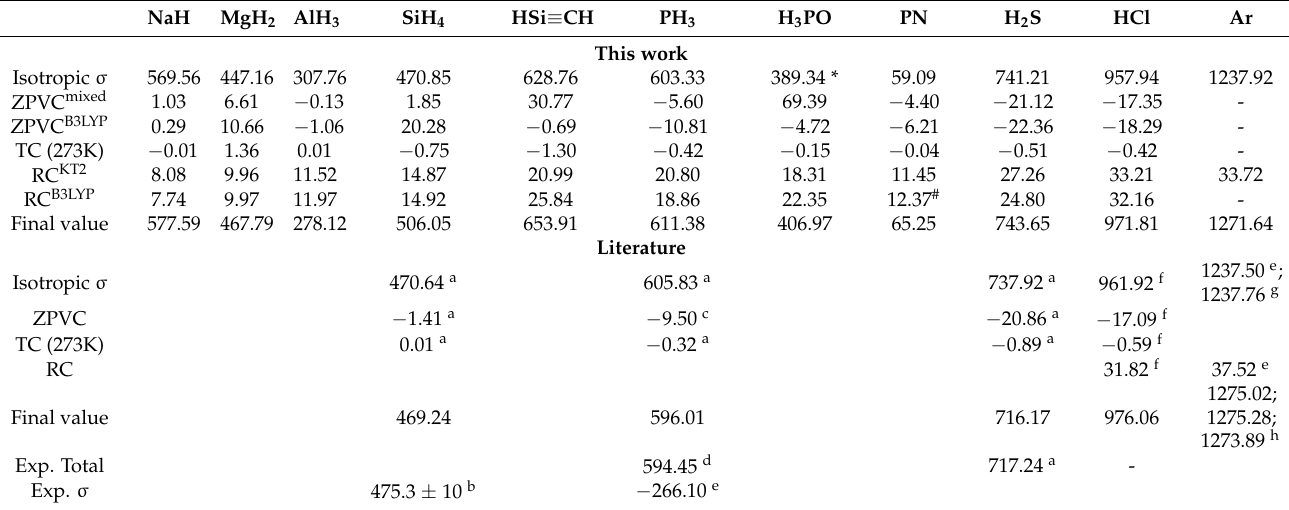
Table 4. Zero-point vibrational, thermal, and relativistic corrections to NMR shieldings of the third- row elements (in